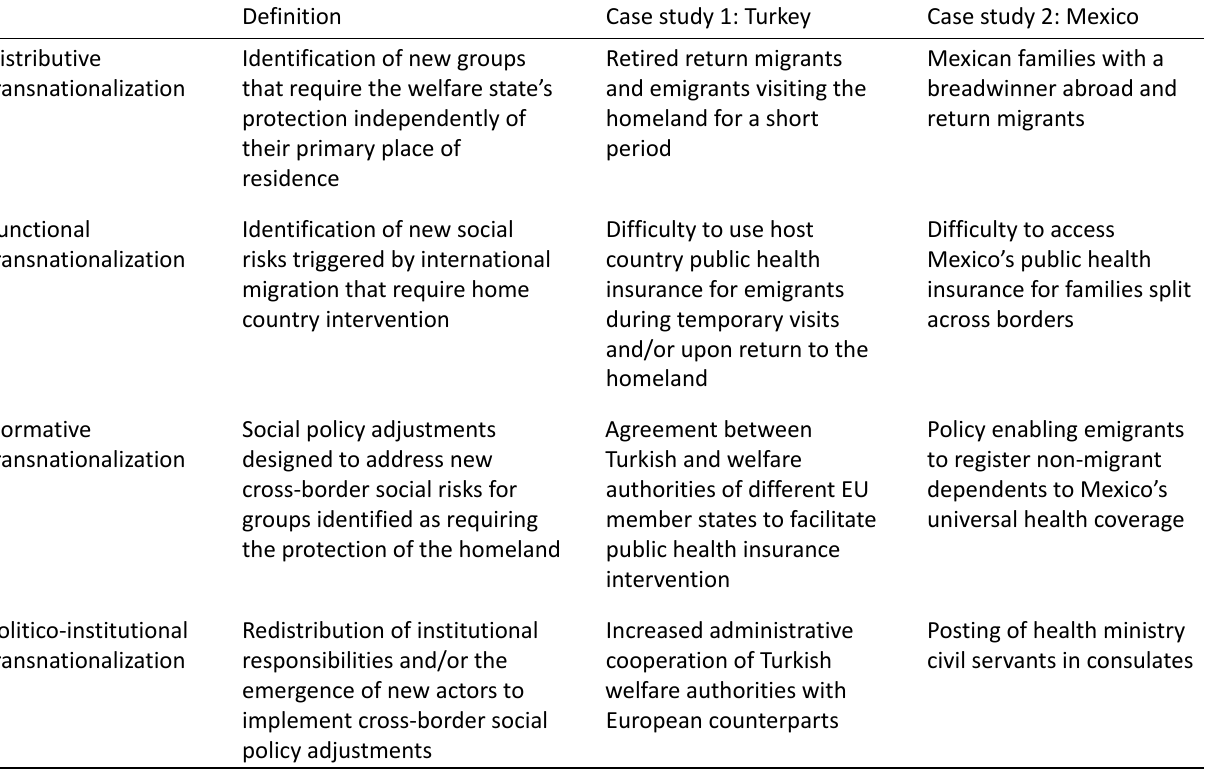
Table 1. The four dimensions of welfare regime